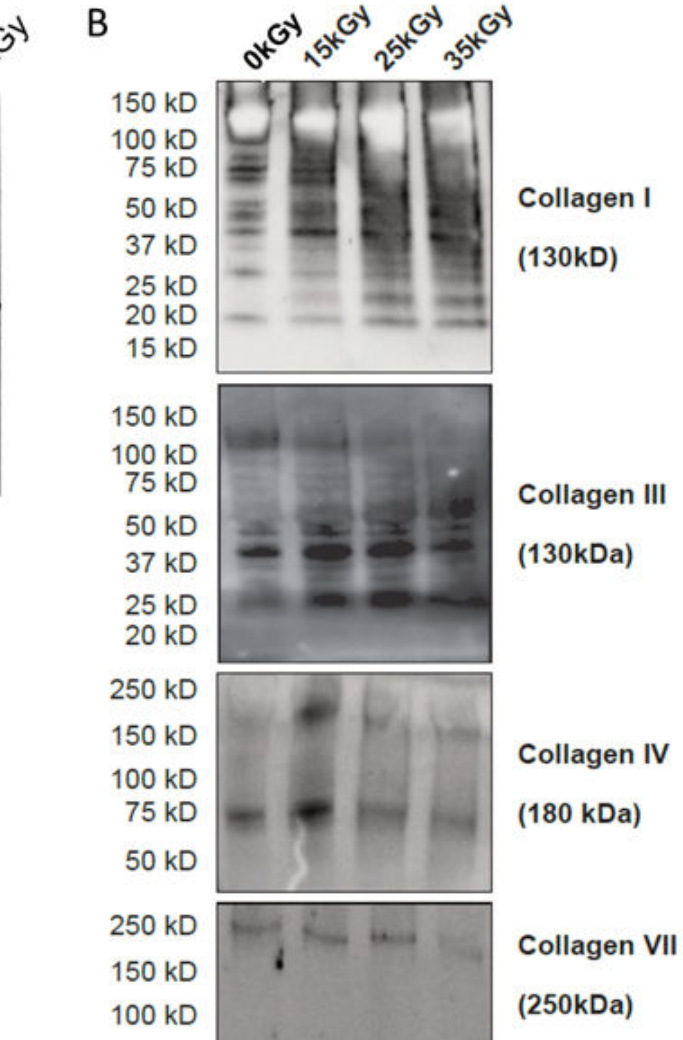
Figure 2. ( A ) Gel electrophoresis of the irradiated hADMs, digested with pepsin. From left to right: non-irradiated (0 kGy) control, and 15, 25, 35 kGy—irradiated samples. ( B ) Representative immunoblots from targeted analysis of collagen I, III, IV, and VII in hADM